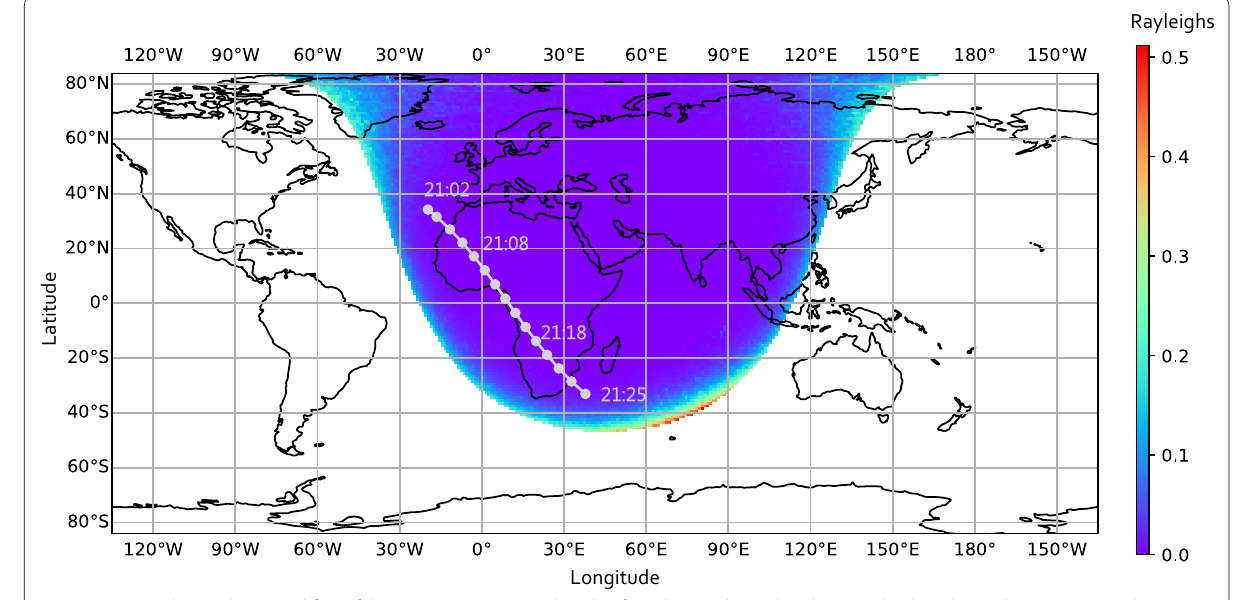
Fig. 9 Estimated omnidirectional flux of the 83.4 nm EUV at an altitude of 400 km on the nightside (in Rayleighs). The sunlit region at 400 km altitude is masked and only the flux in the umbra of the Earth is